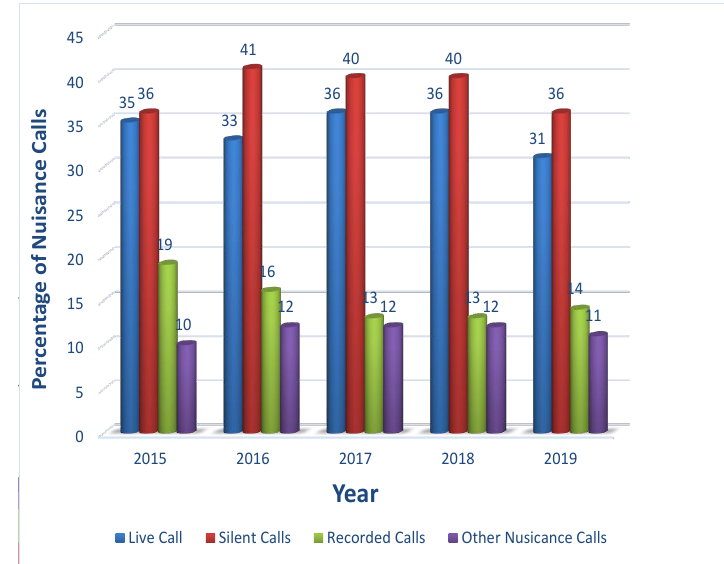
Figure 2. Statistics of users receiving spam calls